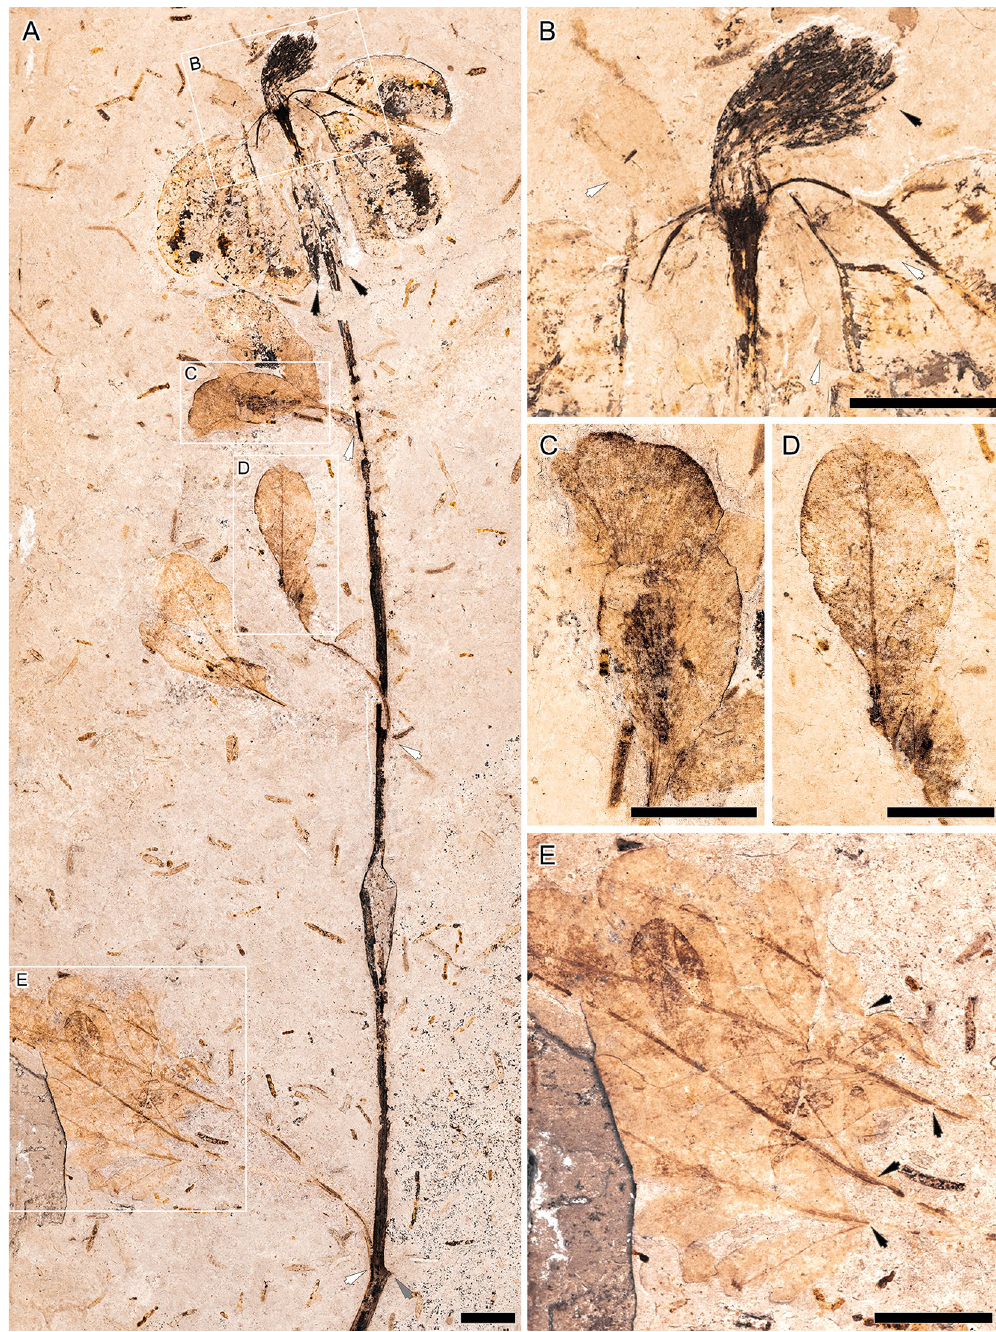
Figure 1. Santaniella lobata gen. nov. et sp. nov. ( A–E ) holotype (MB. Pb. 1998/691). ( A ) general view of holotype showing several leaves and a terminal aggregate fruit, with 5–6 stipitate multi-seeded follicles (white arrows point to leaf attachment, gray arrow to a putative opposite leaf, and black arrows to pair of distal most leaves); ( B ) close-up on follicles attachment to the receptacle, surrounded by 3 outer reflexed (white arrows) and several inner erect and laciniate persistent perianth-like organs (black arrow); ( C – E ) close-up on leaves showing a gradual acropetal reduction in organization and size from ( E ) to ( C ); ( C , D ) leaf type II. ( E ) leaf type III with four lobed leaflets (black arrows point to primary veins). Scale bars = 1